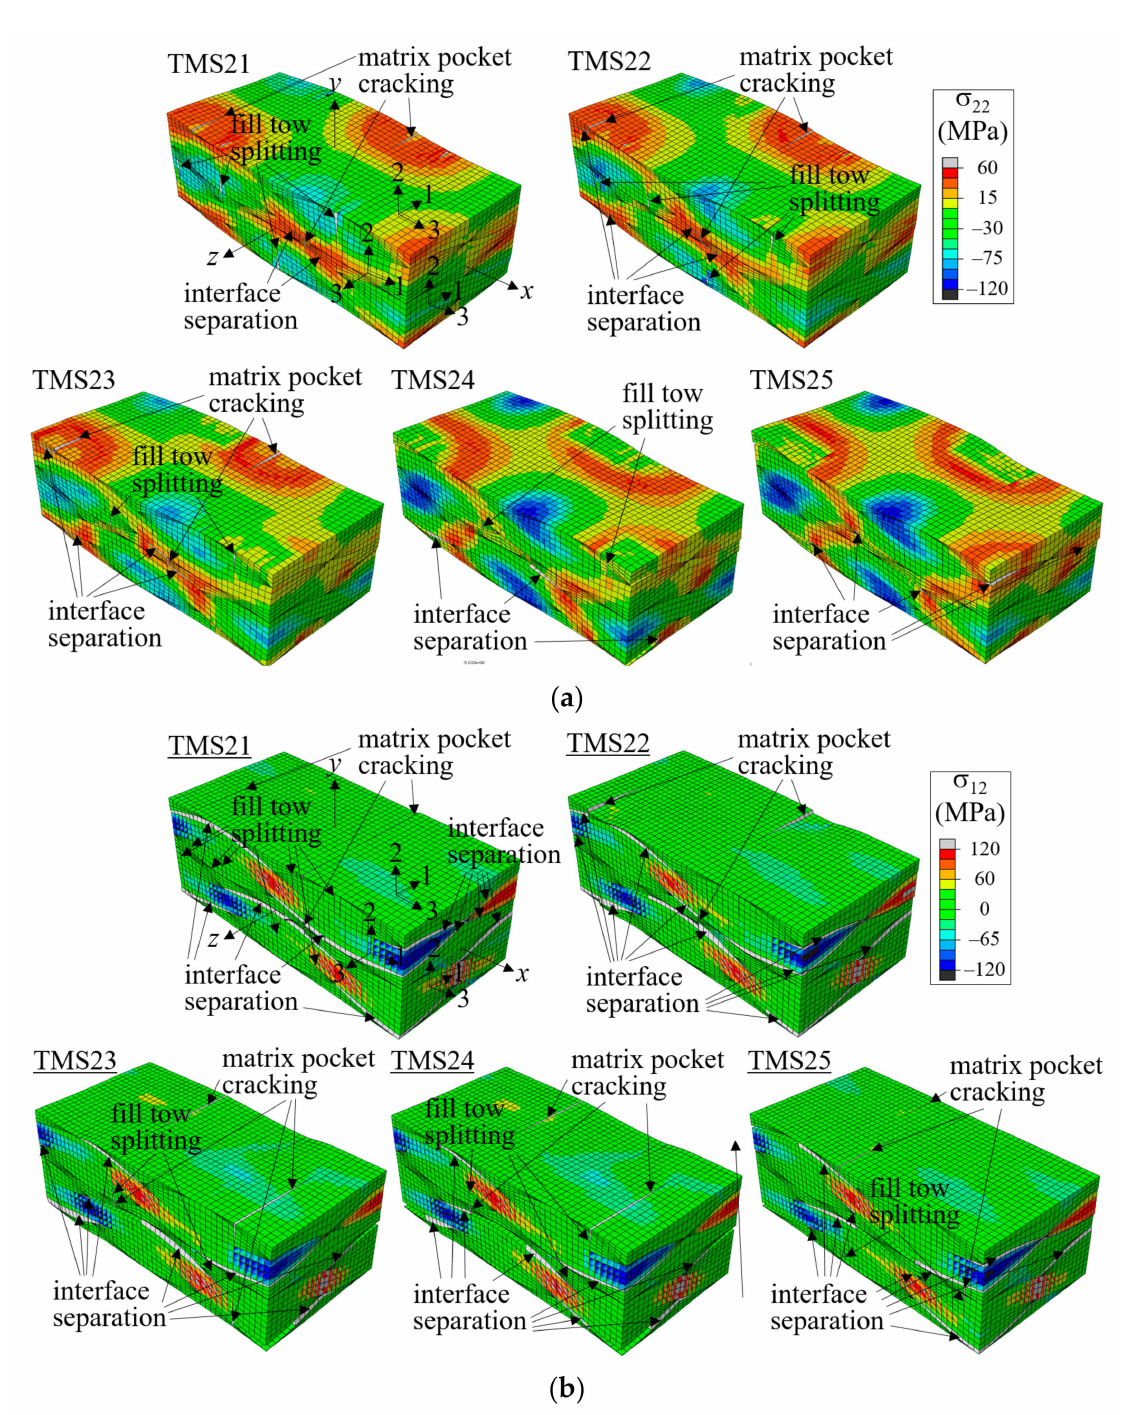
Figure 26. Failure development of two-ply shifted model with TMS defect: ( a ) σ 22 stress distribution at ˆ ε xx = 0.00969 (deformation scale factor = 5); and ( b ) σ 12 stress distribution at ˆ ε xx = 0.0138 (deformation scale factor =